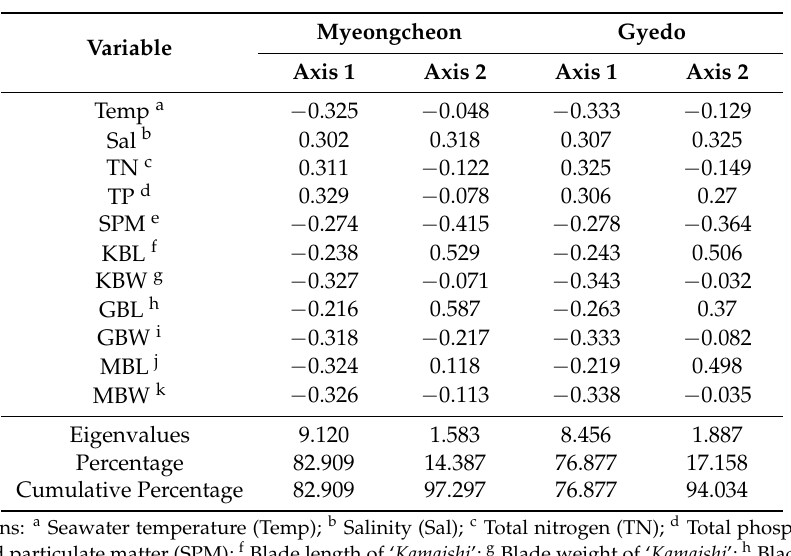
Table 6. Eigenvalues and loading factors from a PCA based on three U. pinnatifida cultivars at Myeongcheon and Gyedo aquafarms between January and May 2003.